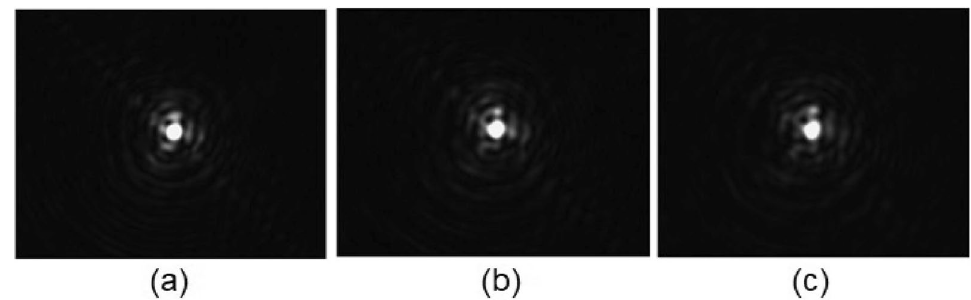
Figure 11. Negative lens focal spot for ( a ) f = − 200 cm, ( b ) f = − 147 cm, ( c ) f = − 120 cm.